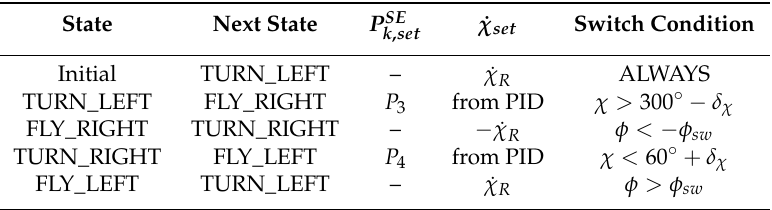
for position is k , set